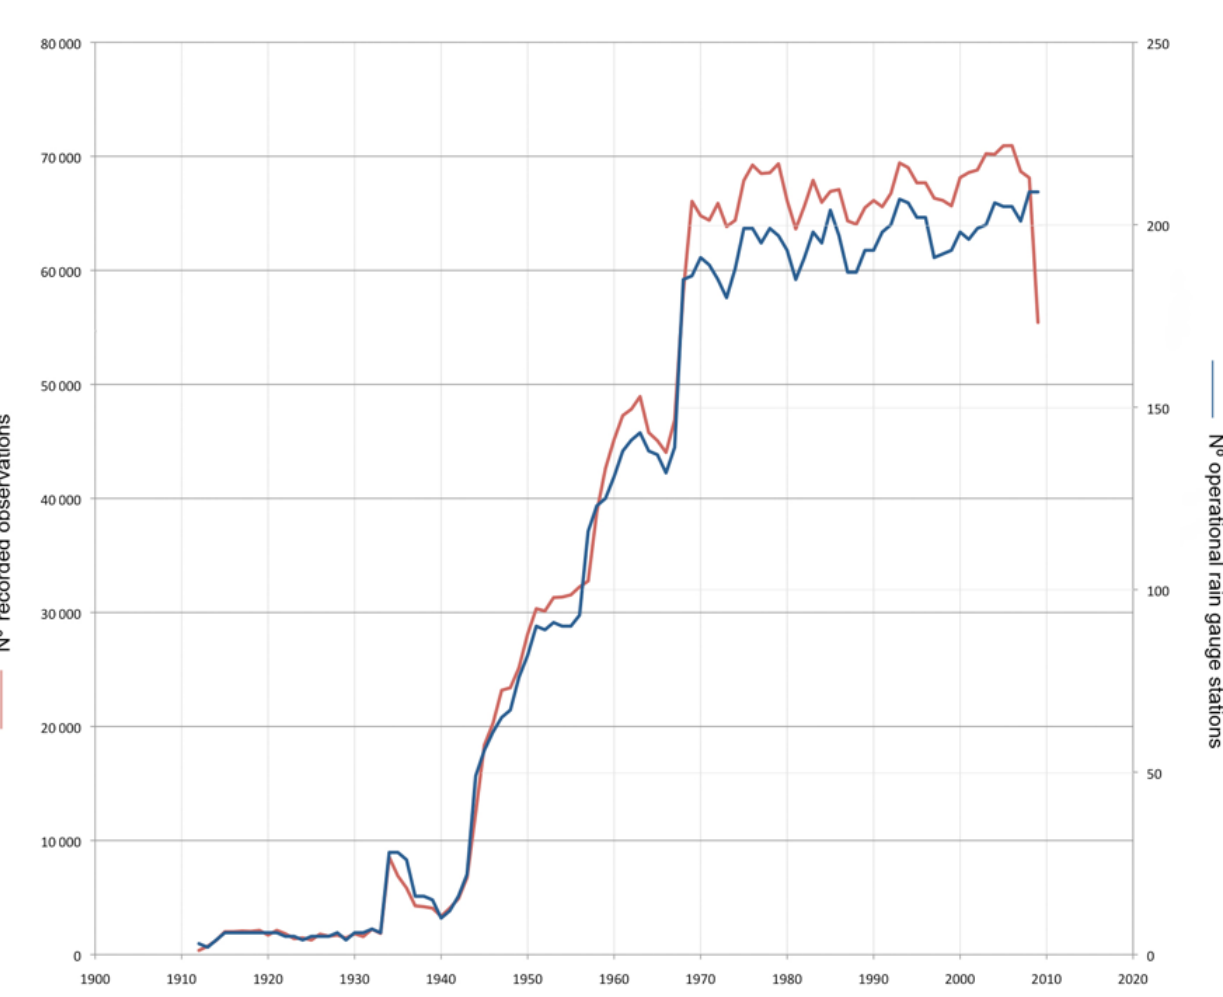
Figure 3. Evolution of (red) total number of annual rainfall records; (blue) number of operational rain-gauge stations per year across the Balearic Islands in the AEMET